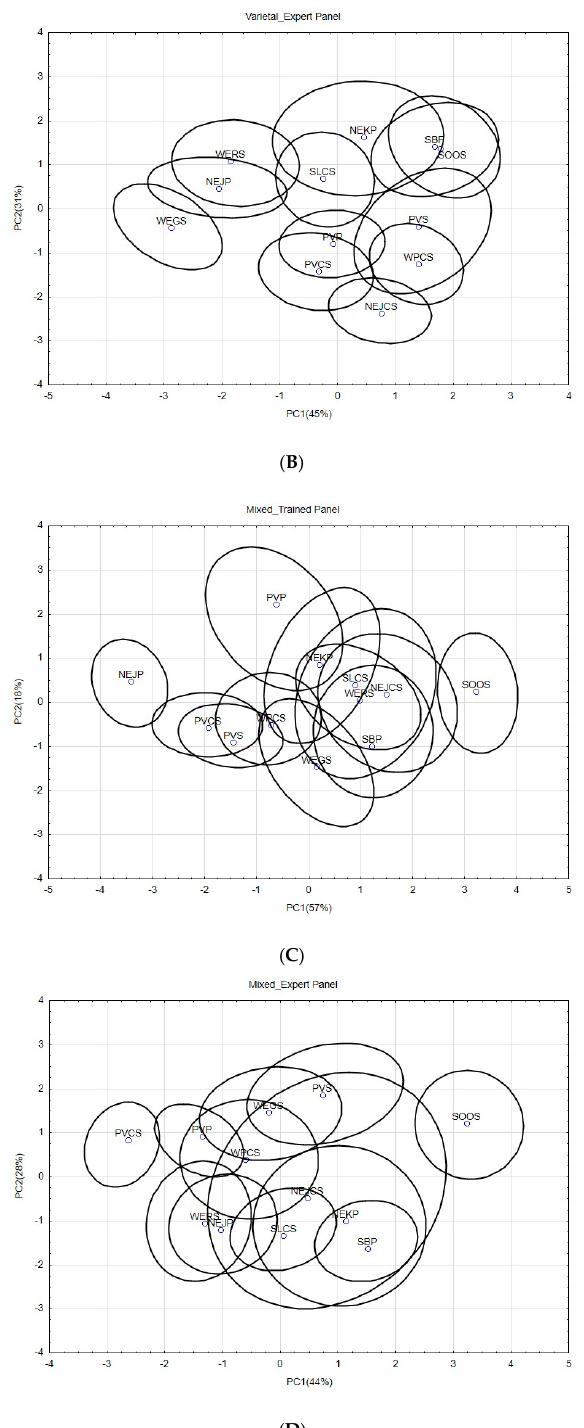
Figure 1. Principal component analysis performed on the sensory variables given by the two panels in the two tasting modalities. ( A ) Configuration of the sample distribution as obtained from the scores given by the trained panel within the “varietal” tasting modality; ( B ) configuration of the sample distribution as obtained from the scores given by the expert panel within the “varietal” tasting modality; ( C ) configuration of the sample distribution as obtained from the scores given by the trained panel within the “mixed” tasting modality; ( D ) configuration of the sample distribution as obtained from the scores given by the expert panel within the “mixed” tasting modality.